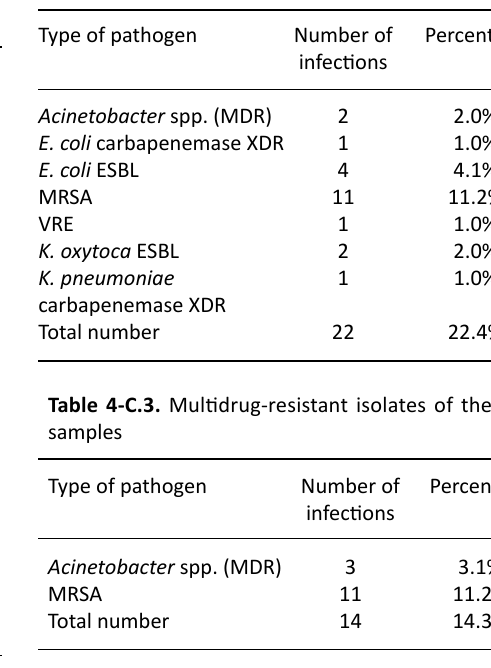
Table 4-c.2. High drug-resistant and MDR isolates of the pus